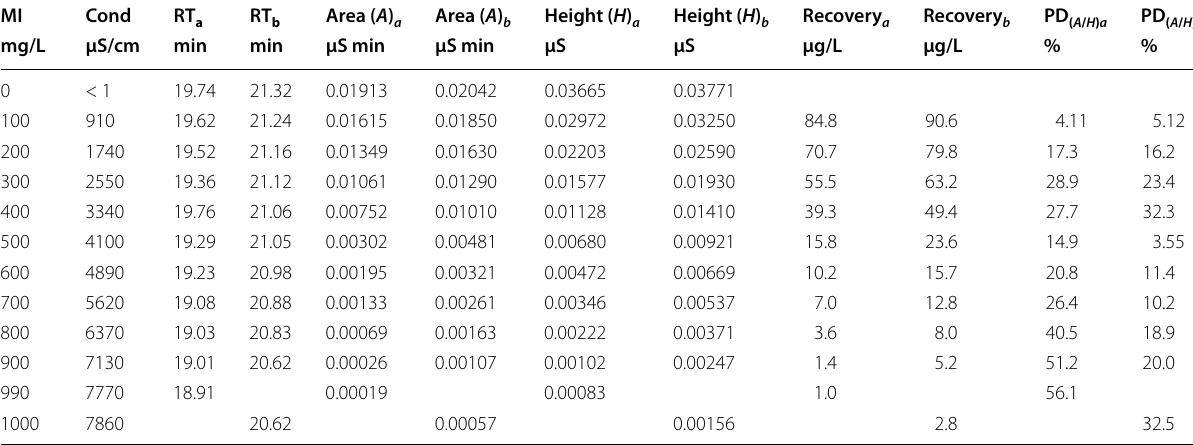
10 µg/L, average of three replicates) =